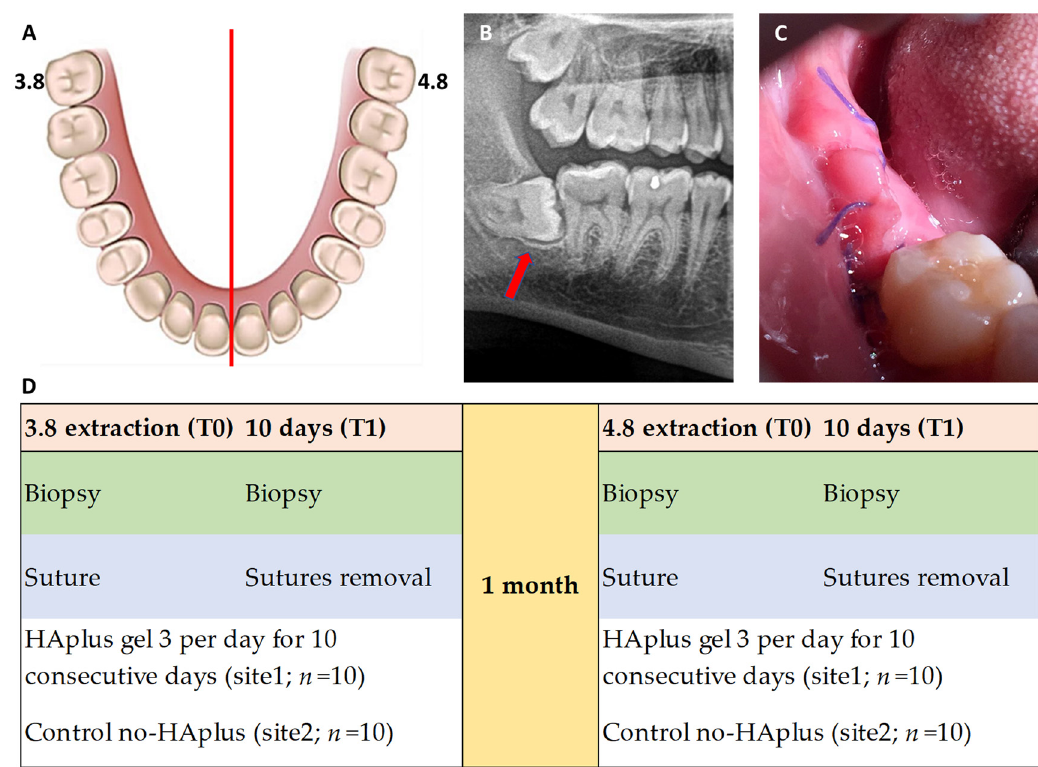
Figure 1. ( A ) Graphical representation of split-mouth design involving third molars 3.8 and 4.8; ( B ) red arrow indicates a mesioangular third molar at orthopantomography; ( C ) intraoral photograph shows post-extractive site at 10 days with flap closure via the Donati suture technique with consequent excesses of tissue to maintain tensile strength and create a stable gingival coverage for better healing of the alveolar socket. ( D ) Post-extraction treatment regimens tested: test sites were treated with HAplus (Aminogam gel ® Errekappa Euroterapici spa) gel, while control sites were not treated with any topical substances (no-HAplus).